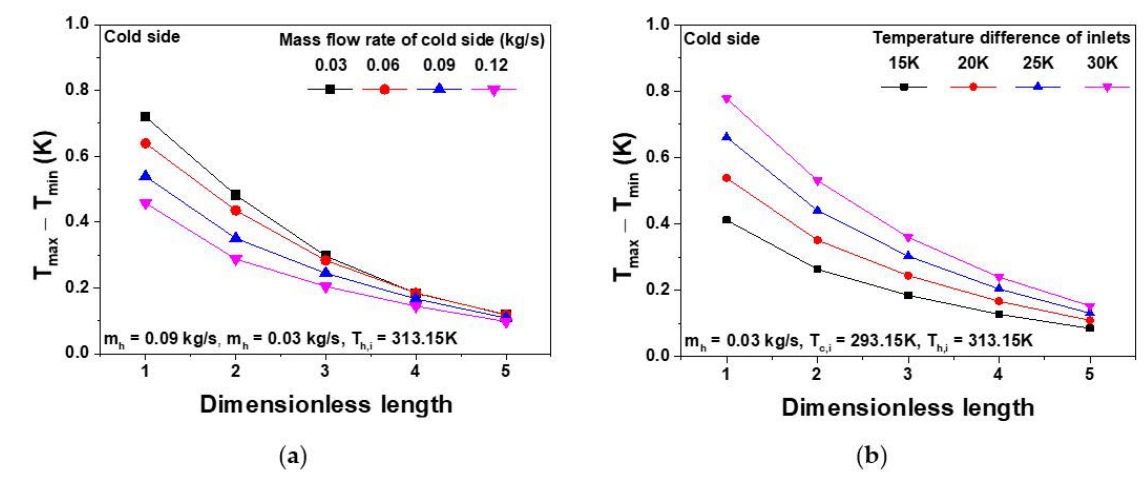
Figure 10. Maximum and minimum temperature difference according to a dimensionless length: ( a ) according to the mass flow rate of the cold side, ( b ) according to the inlet